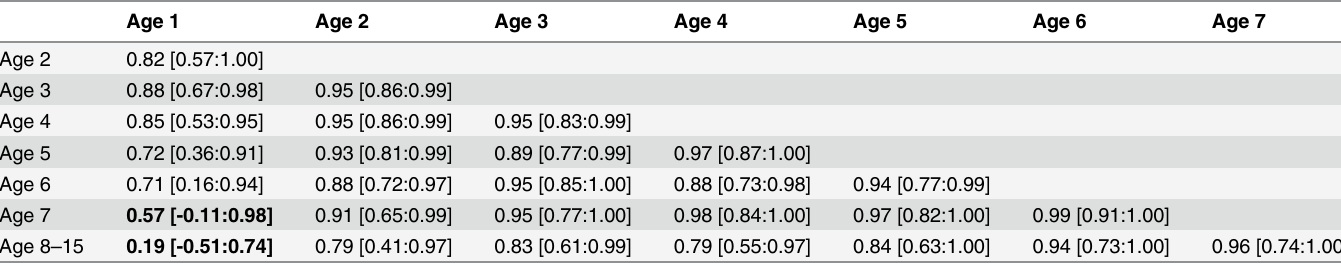
Table 6. Results of genetic correlations between age-classes for ejaculate size.